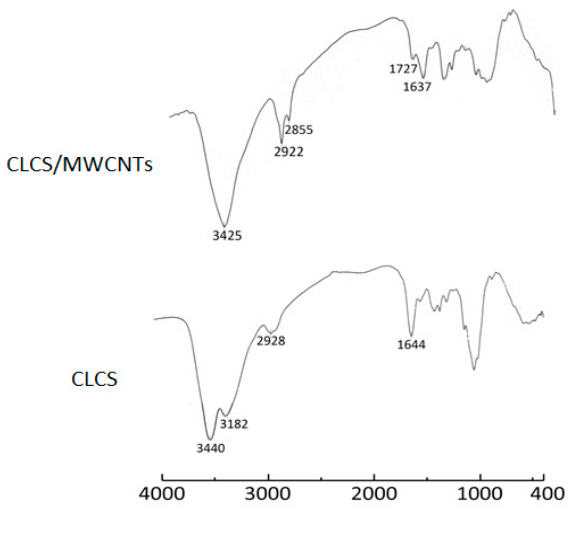
Figure 3 . The FTIR spectra of CLCS and CLCS/MWCNTs composite. Figure 3. The FTIR spectra of CLCS and CLCS/MWCNTs composite.